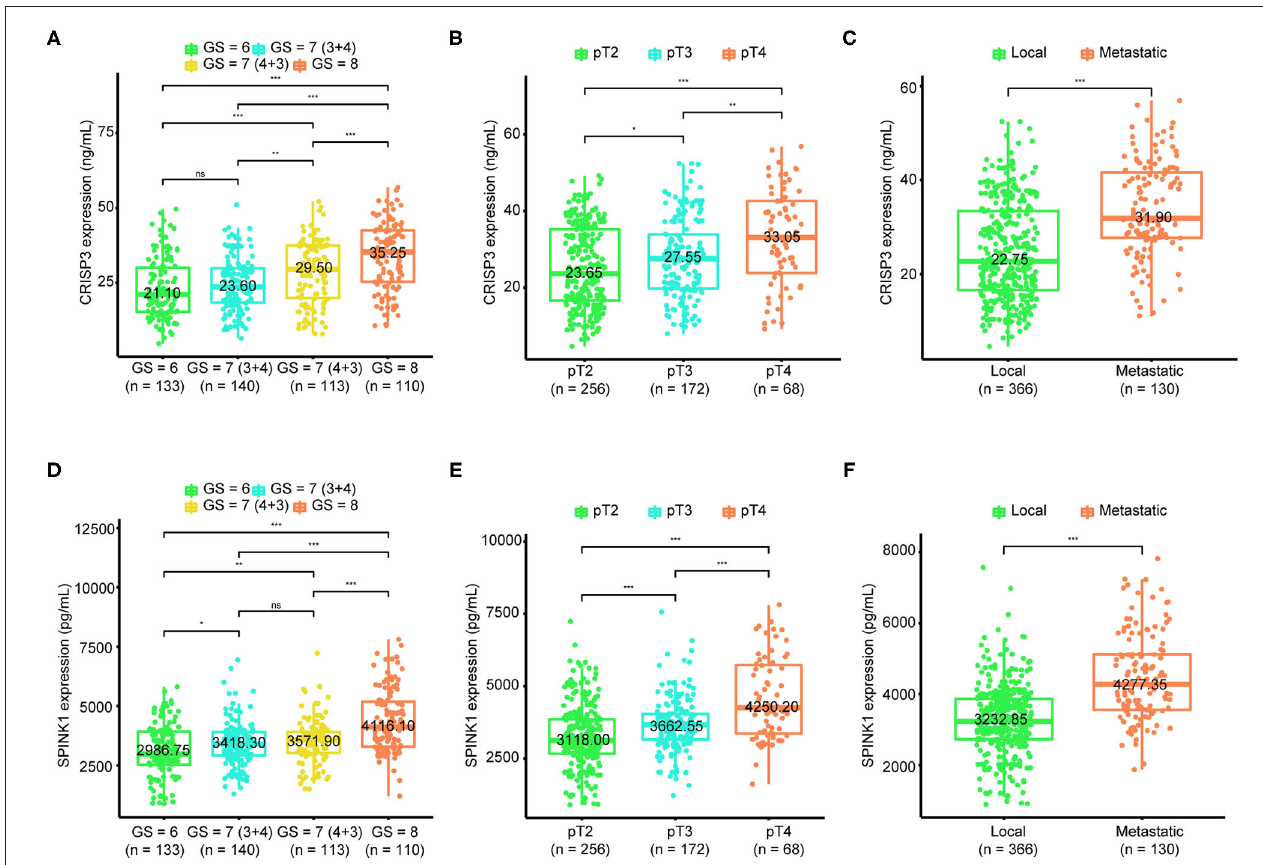
FIGURE 1 | Association of cysteine rich secretory protein 3 (CRISP3) and serine peptidase inhibitor Kazal type 1 (SPINK1) with Gleason score, pathological T stage, and metastasis. The boxplot shows CRISP3 levels increase with the progression of Gleason score (A) , the progression of pathological T stage (B) , and the progression of metastasis (C) . The boxplot plot shows SPINK1 levels increase with the progression of Gleason score (D) , the progression of pathological T stage (E) , and the progression of metastasis (F) . P values are calculated using the Wilcoxon test. * indicates P < 0.05, ** indicates P < 0.01, *** indicates P < 0.001.